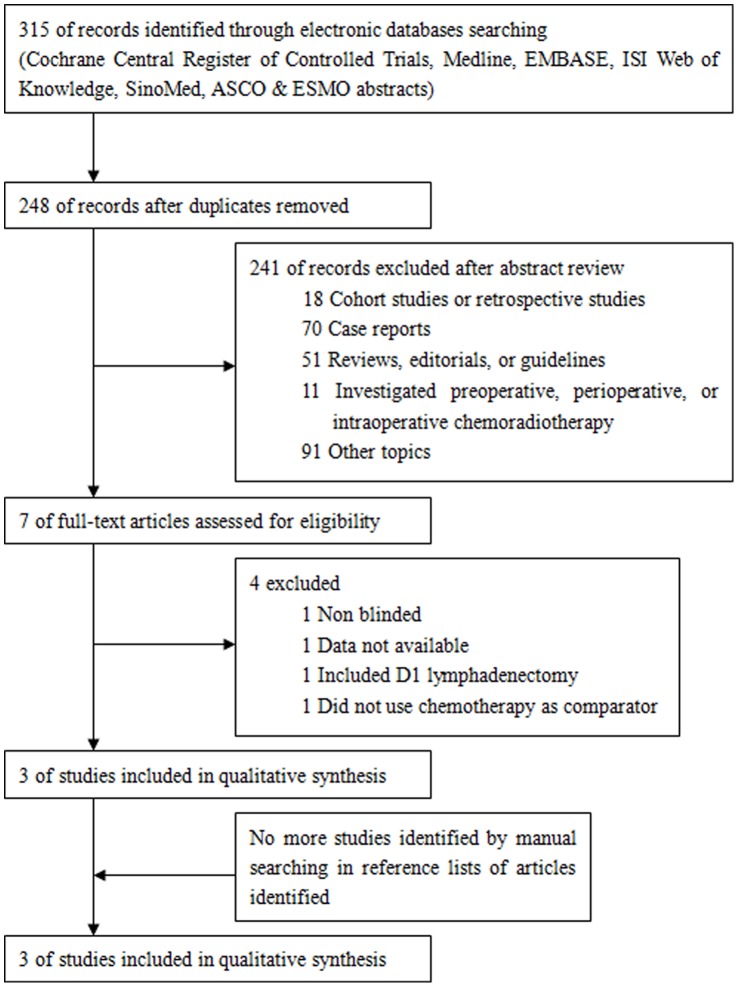
Flow chart of randomized controlled trials selection.